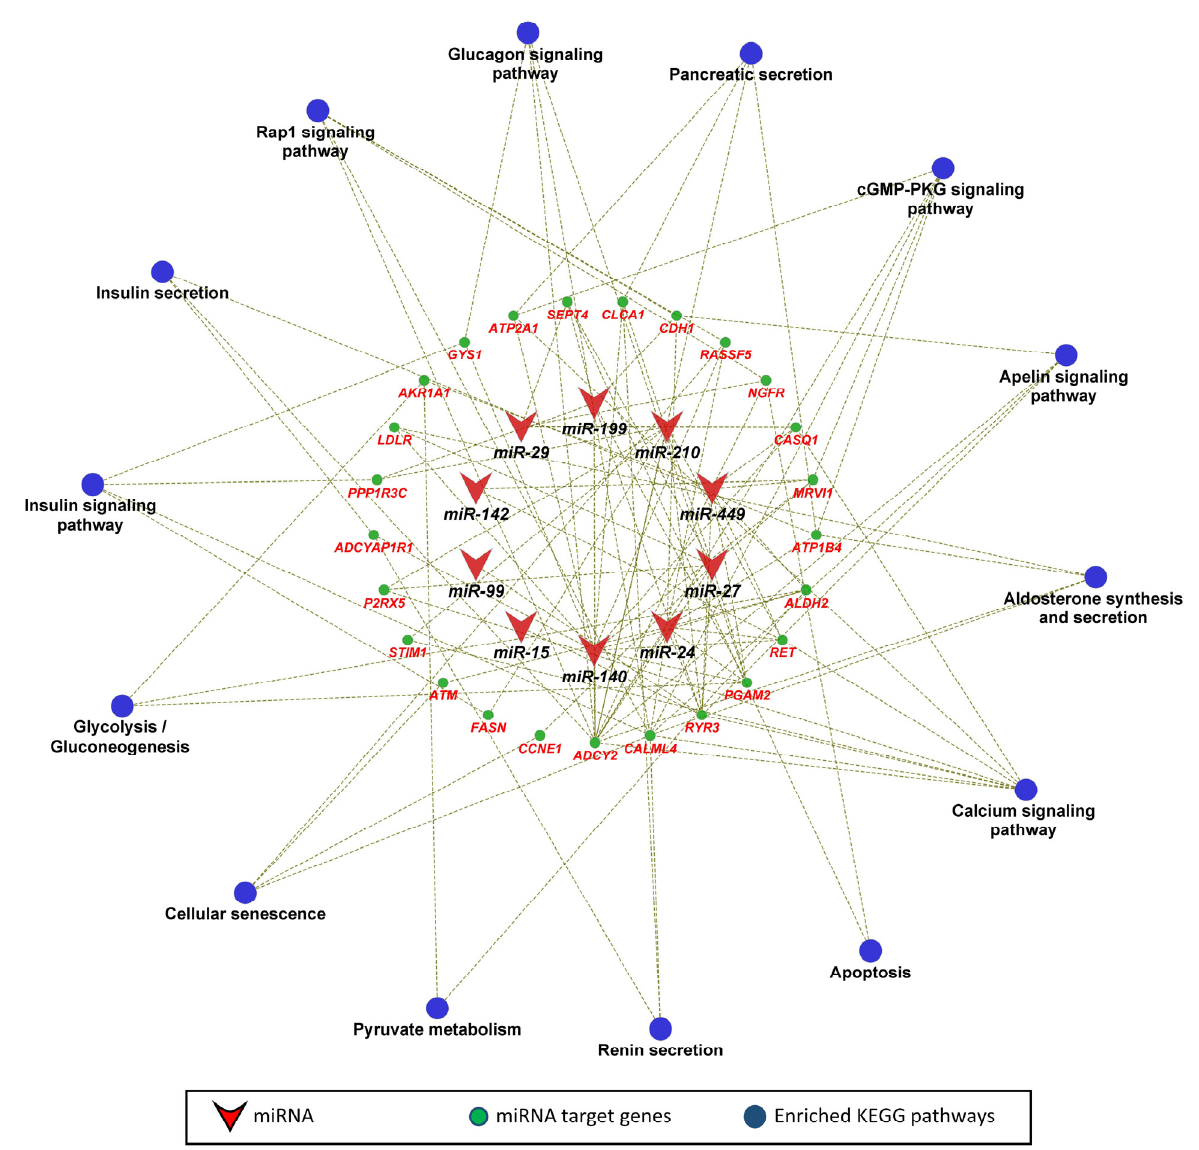
Figure 5. KEGG pathway enrichment analysis of fetal weight-correlated target genes of fetal weight-correlated miRNAs. KEGG pathways with a p ≤ 0.05 were considered significantly enriched. A complete list of KEGG pathways significantly enriched by miRNA target genes is provided in Table S6.